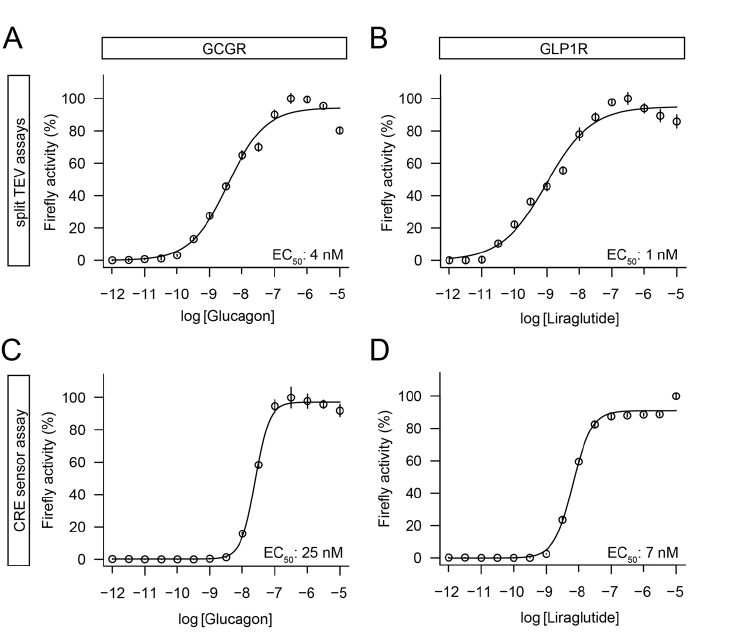
Figure 4. Dose–response curve analysis identified robust agonist assays for GCGR and GLP1R using both target-based split TEV and pathway-based CRE reporters. ( A ) Dose–response assay for native GCGR using glucagon as stimulus and split TEV as readout. Hill slope = 0.741. ( B ) Dose–response assay for GLP1R-V2R using liraglutide as stimulus and split TEV as readout. Hill slope = 0.602. ( C ) Dose–response assay for native GCGR split TEV construct as used in ( A ) using glucagon as stimulus and a CRE reporter as readout. Hill slope = 1.991. ( D ) Dose–response assay for GLP1R-V2R split TEV construct as used in ( B ) using liraglutide as stimulus and a CRE reporter as readout. Hill slope = 1.491. Receptors were stimulated for 6 h. Data represent mean ± s.e.m. Firefly counts were normalized to the minimum and maximum of ligand